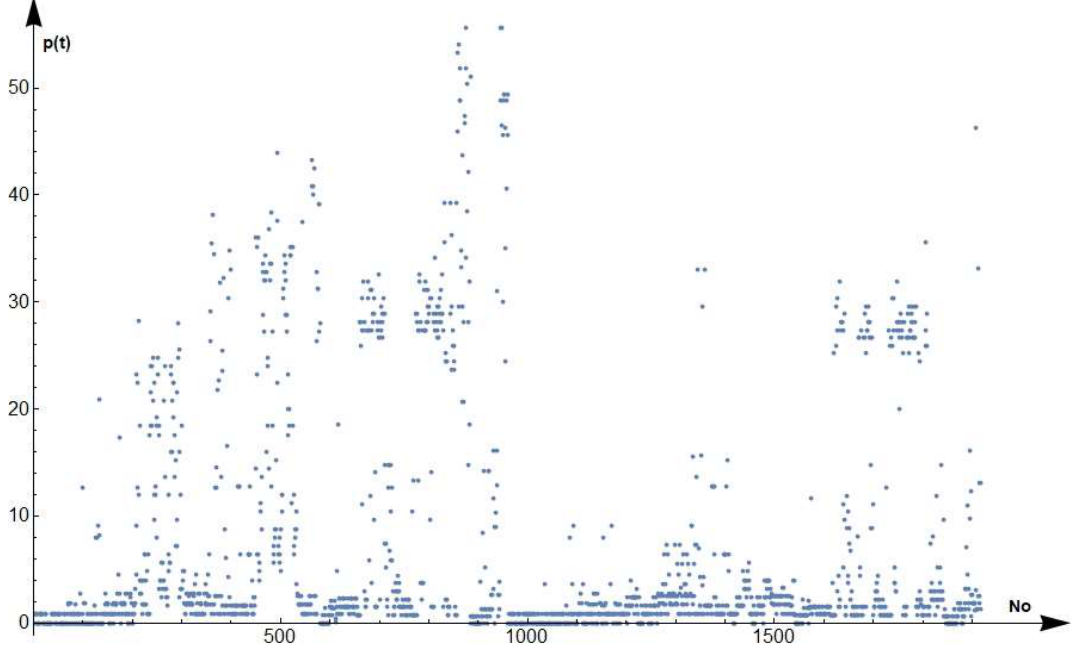
Figure 2. Input corrosion depth database for the LG structural elements.